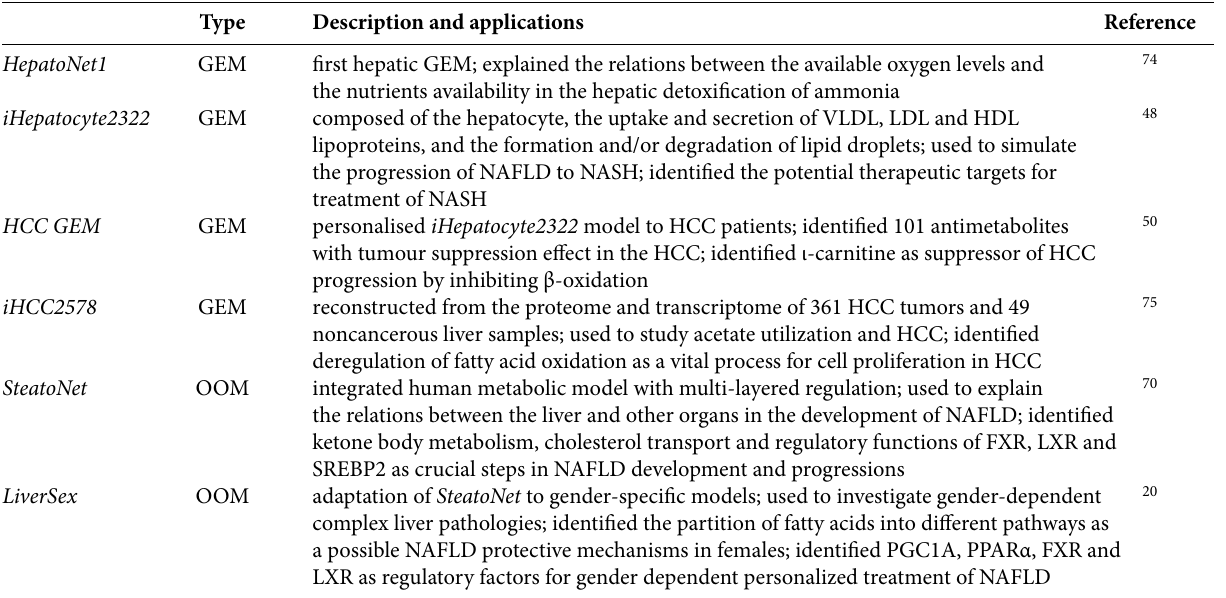
Figure 2: Computational models are complemented with experi- mental, literature and clinical data, which allows their transition towards clinical applications. Table 2: State-of-the-art computational models used in the liver research. Only major large-scale computational models are included within the ta- ble. Abbreviations: GEM – genome scale metabolic models, HCC – hepatocellular carcinoma, NAFLD – non-alcoholic fatty liver disease, NASH – non-alcoholic steatohepatitis, SteatoNet – steatosis